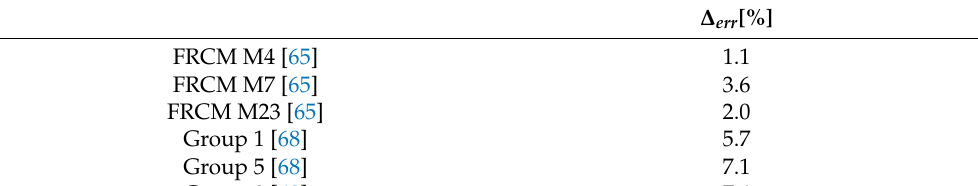
Table 8. Results of comparison.